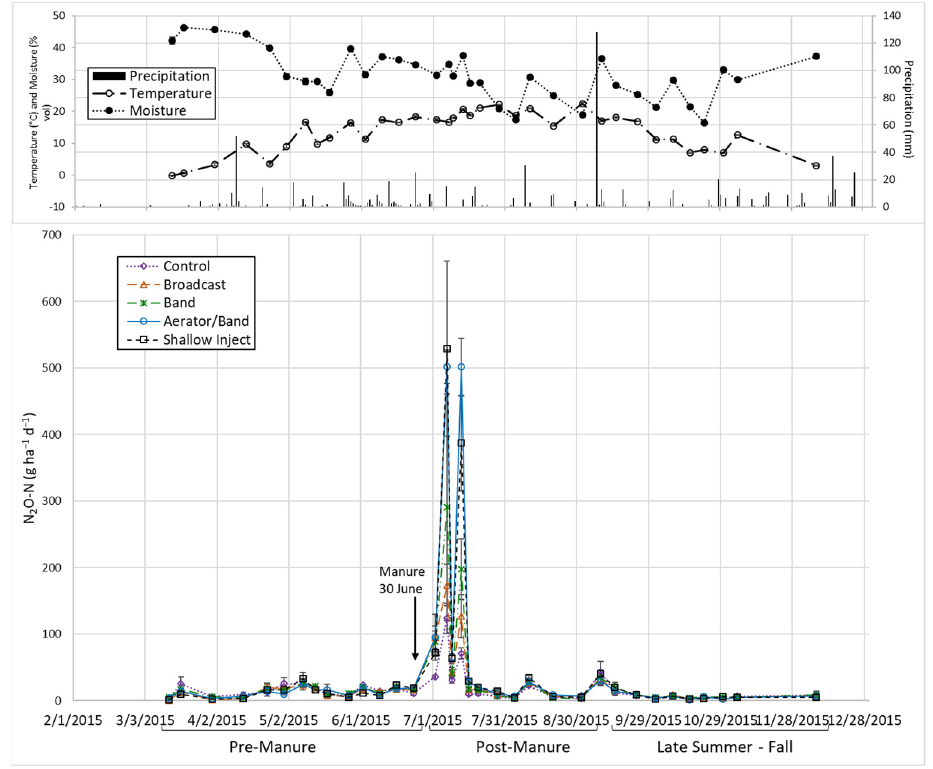
Figure 2. Precipitation, soil temperature and moisture, and daily nitrous oxide (N 2 O-N) fluxes for 2014.